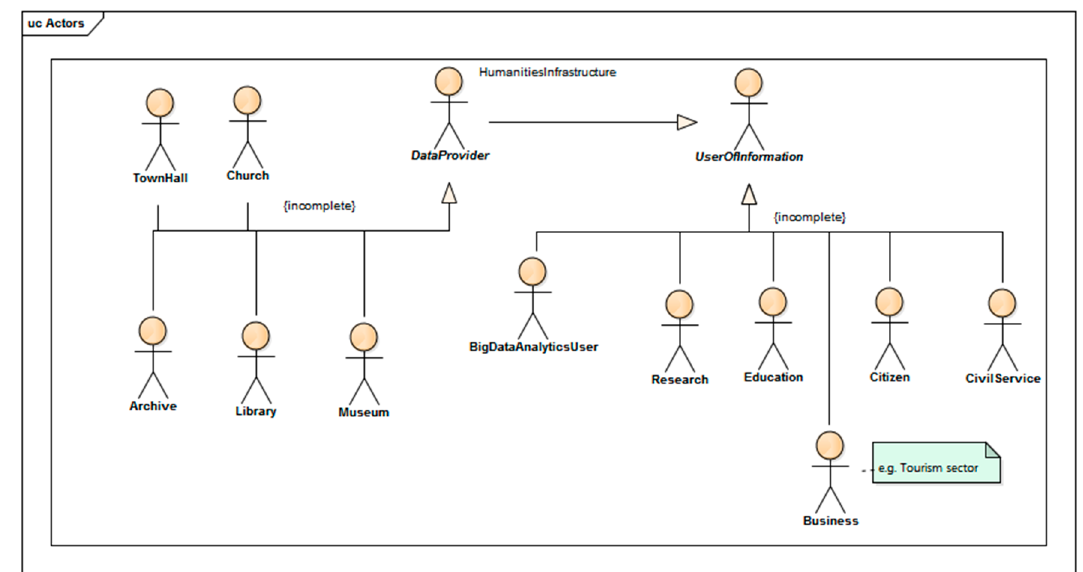
Figure 5. Data providers and users of Infrastructure (source: own work).